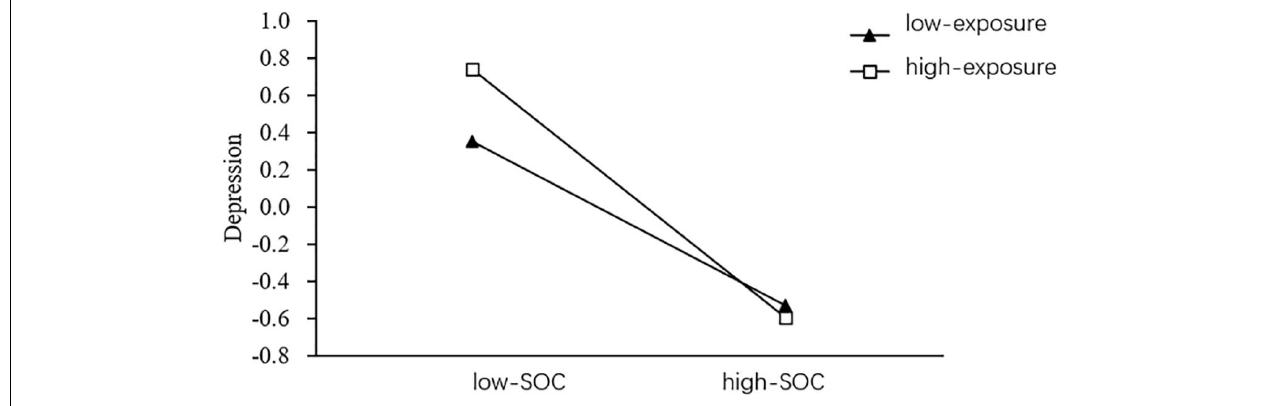
FIGURE 3 | Moderated effect of negative epidemic information exposure between SOC and depression (SOC: sense of coherence; N =